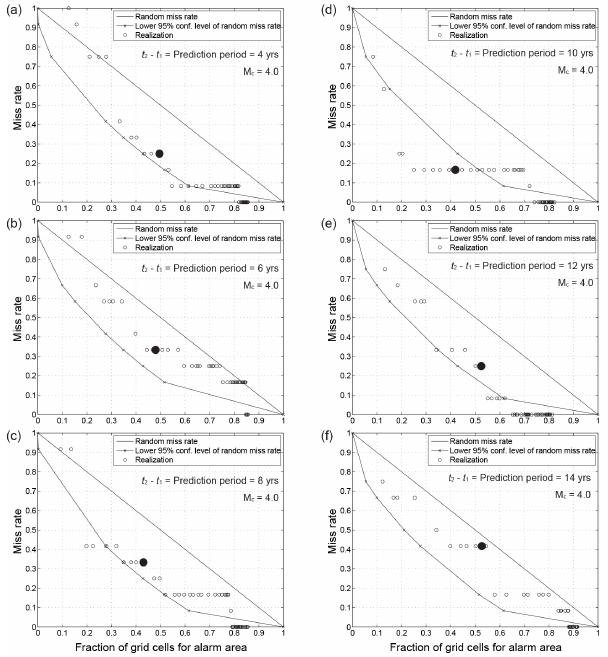
Fig. 10. As in Fig. 9, but for a cutoff magnitude of 4.0.